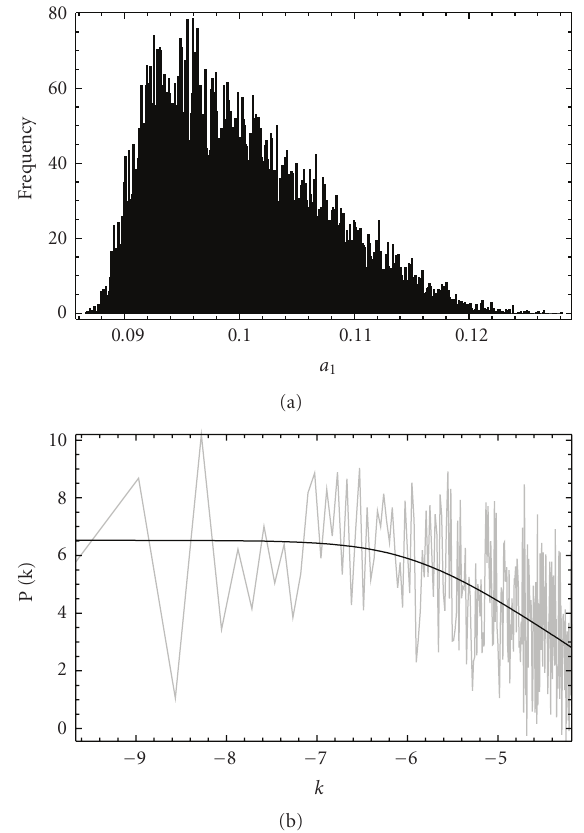
Figure 5: (a) histogram of the sample points for parameter a 1 in Abell 383 coming out the MCMC implementation used to estimate best fit values and errors for our fitting procedure as described in Section 11.5. Binning (horizontal axis) and relative frequencies (vertical axis) are given by automatic procedure from Mathematica6.0. (b) power spectrum test on sample chain for parameter a 1 using the method described in Section 11.5. Black line is the logarithm of the analytical template (146) for power spectrum; gray line is the discrete power spectrum obtained using